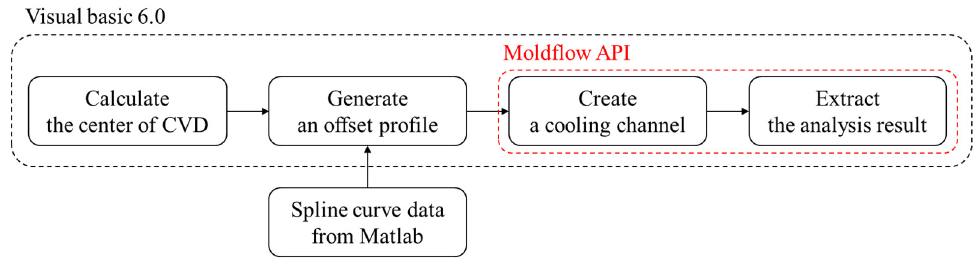
Figure 2. Flowchart for designing the cooling channel.